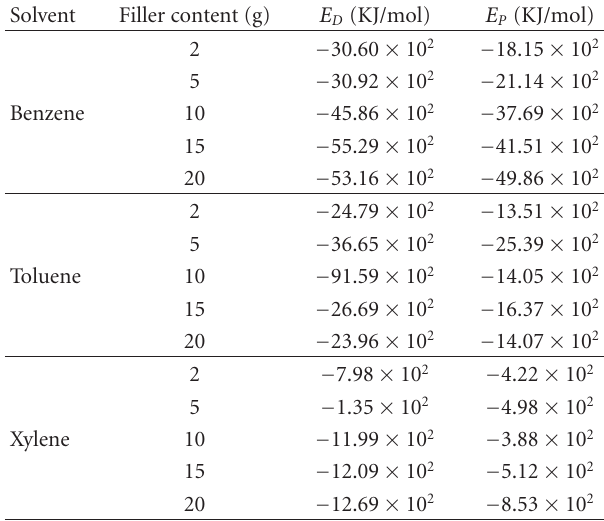
Table 5: Values of activation energy ( E D and E P ) of snail shell powder filled natural rubber (filler particle size, 0.075 μ m).